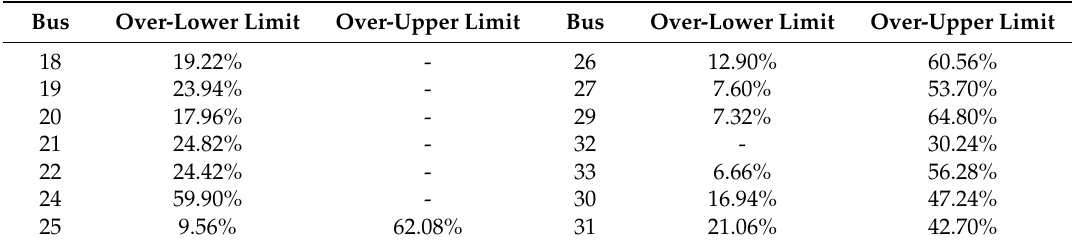
Table 2. Probability of over-limit of bus voltage.